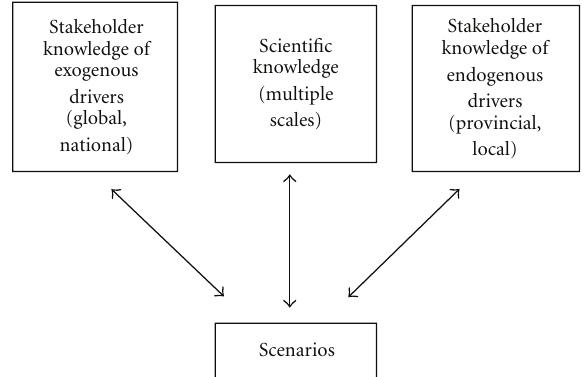
Figure 1: Process of knowledge integration through scenarios. The arrows extend in both directions to indicate an iterative process of information flows between the scenarios and the di ff erent knowledge sets.